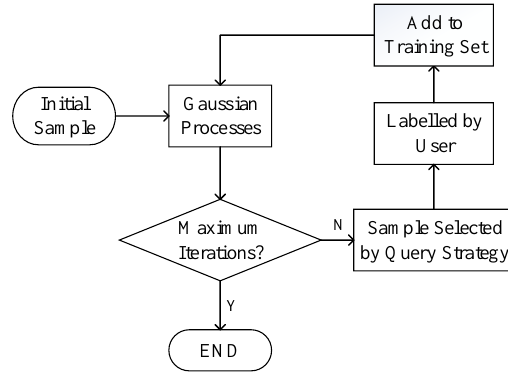
Figure. 2 Active Learning with Gaussian